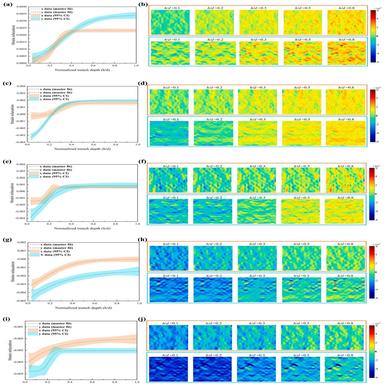
Illustration of the multiscale strain relaxation during the FIB milling step. (a), (c), (e), (g), and (i) illustrate the strain relaxation profile of detected regions in ring-core milled from different machined surfaces along the x and y directions with 95 % CI. (b), (d), (f), (h), and (j) illustrate the corresponding time-resolved HR strain relaxation maps in the x and y directions.